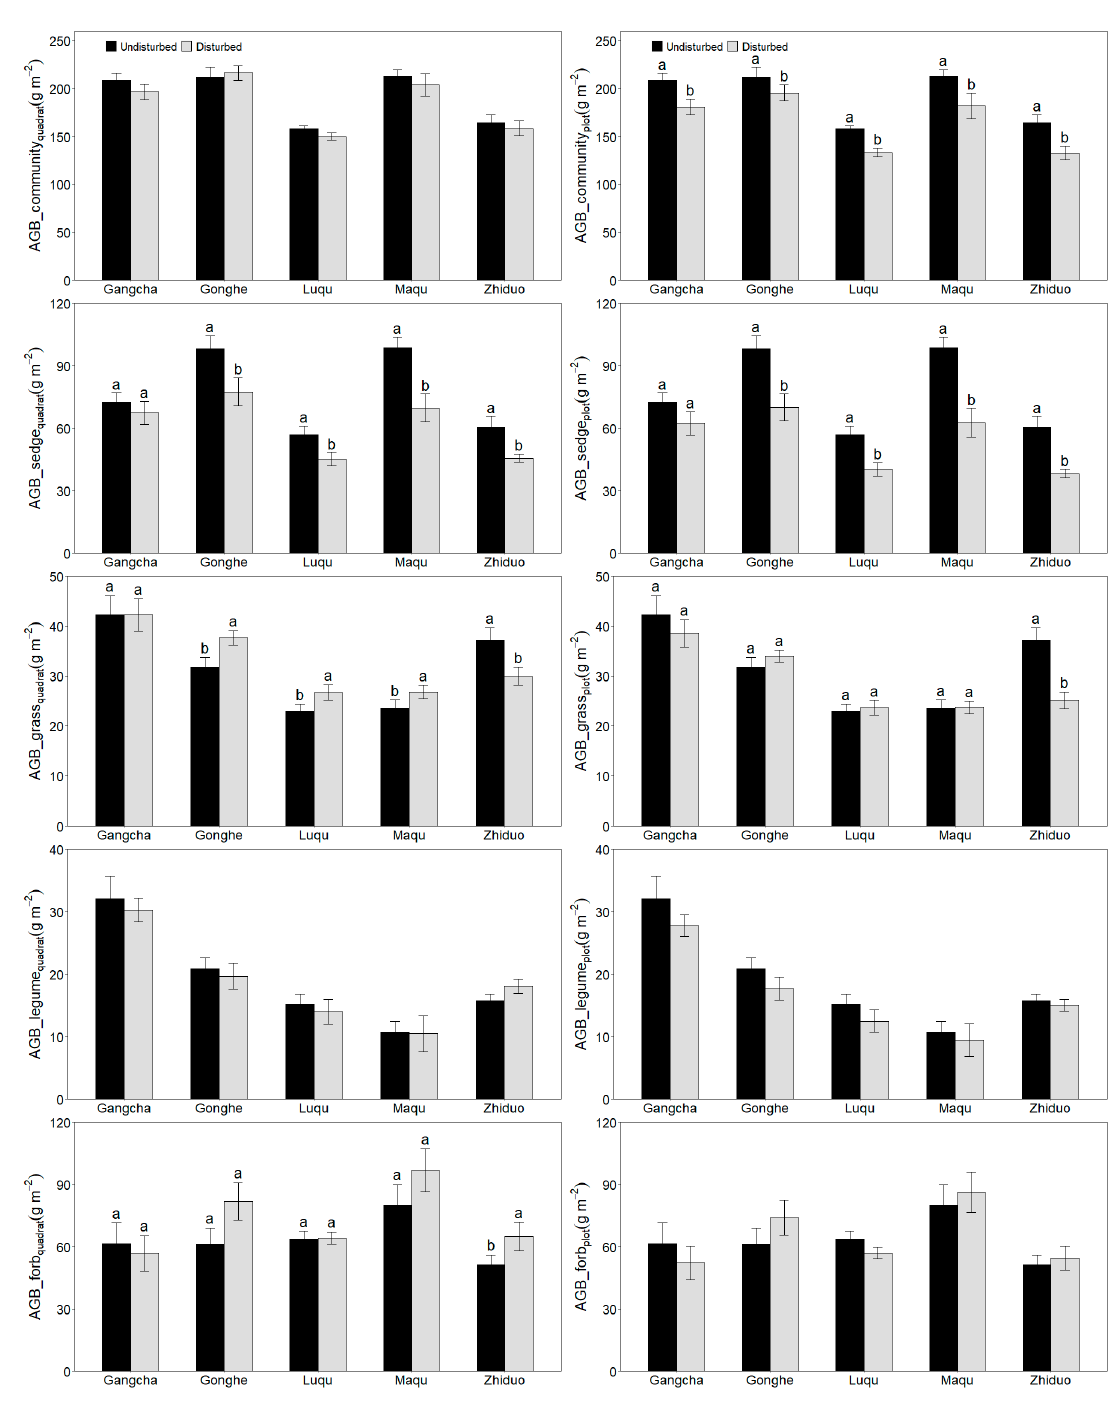
Figure 2. Effect of plateau pika disturbance on plant aboveground biomass at quadrat and plot scales in each site (Mean ± Std. Error). ABG, aboveground biomass. The statistics were from the paired-T test for each site. AGB, aboveground biomass. Different letters indicate a significant difference between the undisturbed plots and disturbed plots at each site ( p < 0.05).